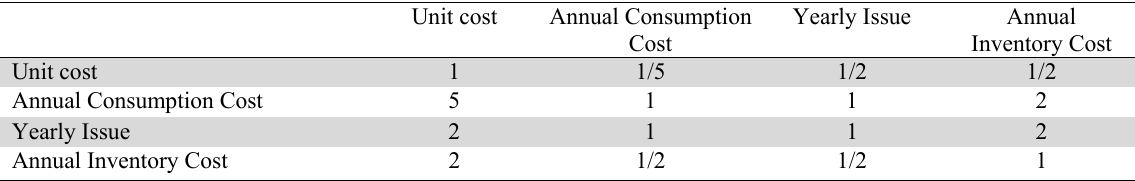
Relative Importance Relation Matrix